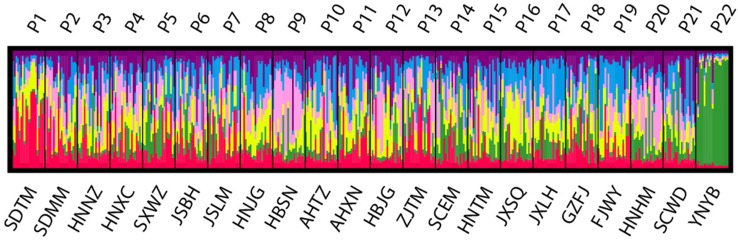
Estimated genetic structure for K = 6 obtained with the program STRUCTURE for 22 populations of Pterocarya stenoptera based on simple sequence repeat (SSR) data. Each vertical bar represents an individual and its assignment proportion into one of five (colored) population clusters (K).